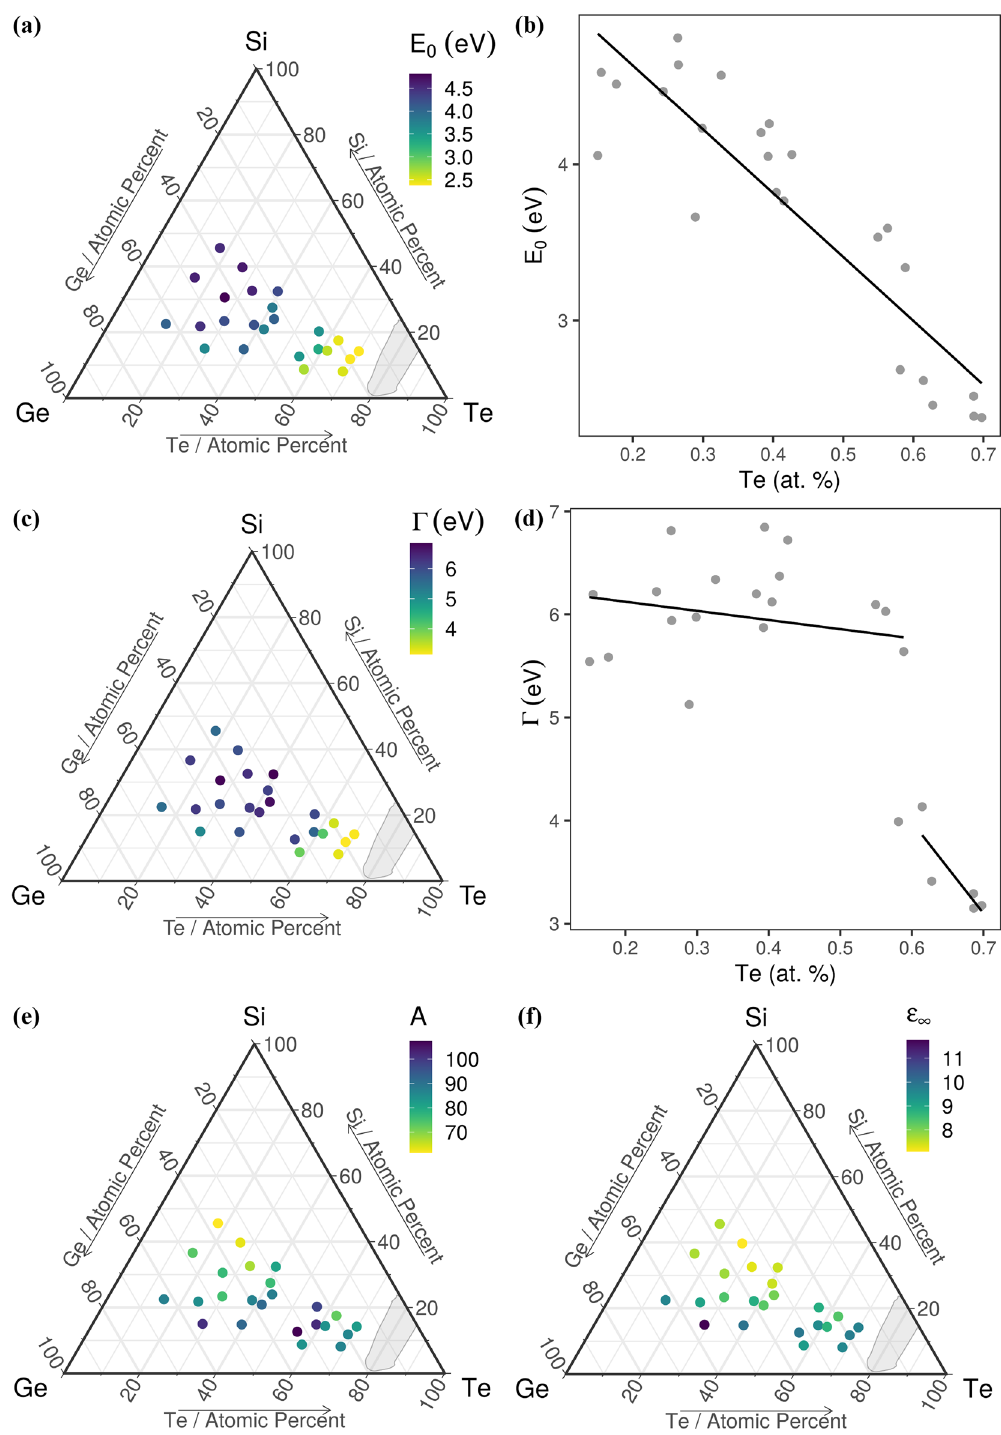
Figure 5. Spectroscopic ellipsometry parameters for the Si–Ge–Te library. Resonance energy, E 0 , as a function of ( a ) composition and ( b ) Te concentration; Broadening parameter of the oscillator, Γ , as a function of ( c ) composition and ( d ) Te concentration; ( e ) Amplitude, A, as a function of composition; and ( f ) Optical dielectric constant, ε ∞ , as a function of composition. The black line in ( b ) and ( d ) is a guide to the eye. Ternary diagrams were generated with the R software [v. 3.6.3] (R: A language and environment for statistical computing, R Core Team, R Foundation for Statistical Computing, Vienna, Austria (2020) http:// www.R- proje ct. org/.) using the package ggtern [v. 3.3.0] (https:// cran.r- proje ct. org/ web/ packa ges/ ggtern/ index.